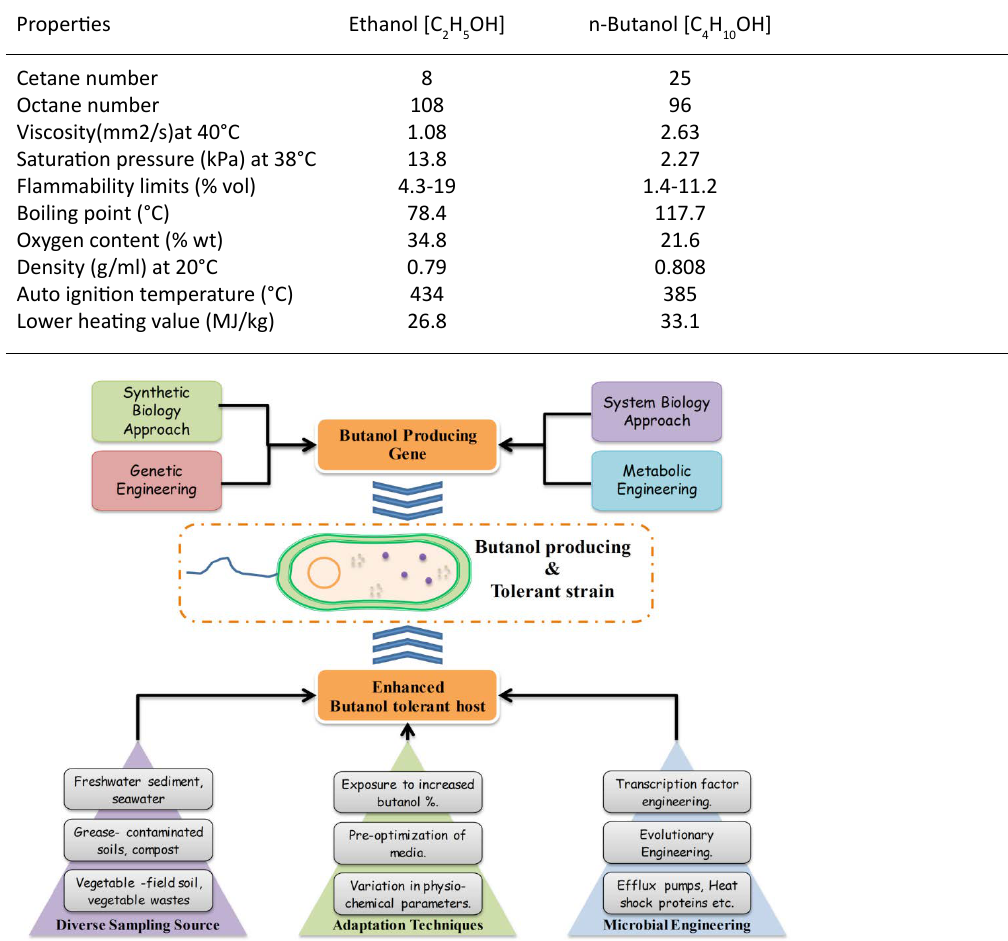
table 2. Difference in physiochemical properties of ethanol and butanol Properties